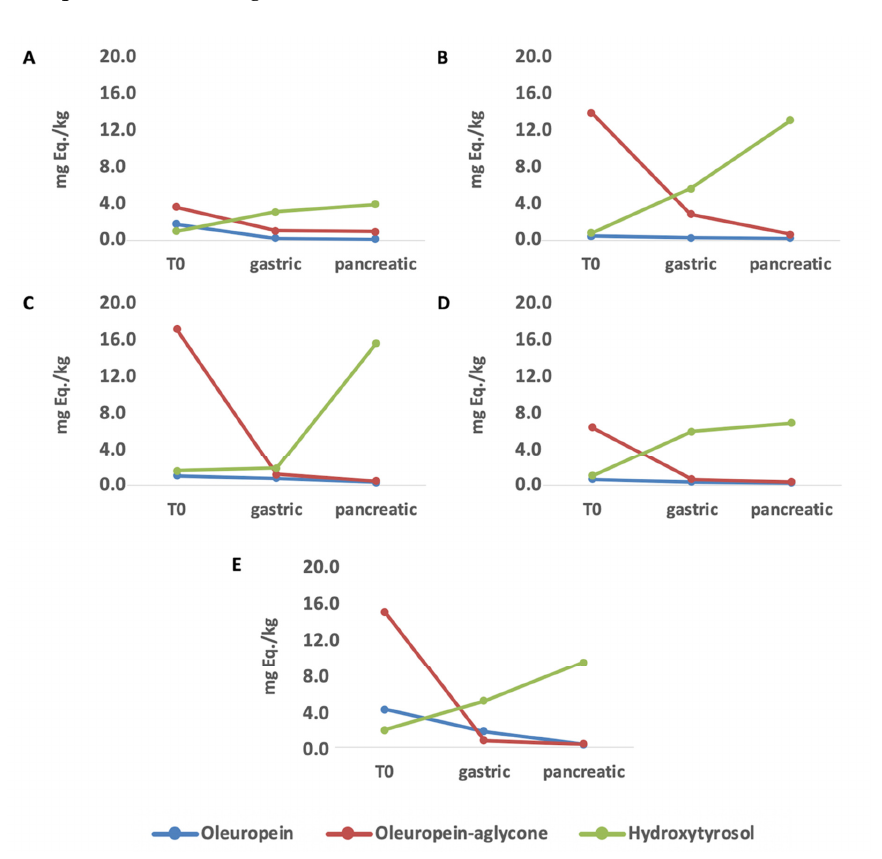
Figure 3. Main changes during in vitro gastrointestinal digestion involving oleuropein, oleuropein- aglycone and hydroxytyrosol in the different EVOO samples. ( A ) Frantoio, ( B ) Kalamon, ( C ) Leccino, ( C ) Leccino, ( D ) Picholine, ( E ) ( D ) Picholine, ( E ) Picual.